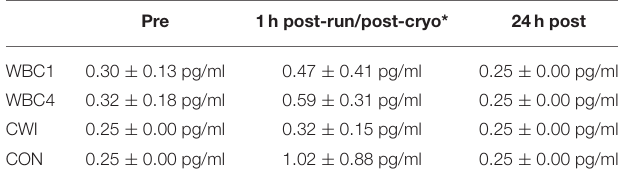
TABLE 3 | Plasma IL-6 response for WBC1, WBC4, CWI, and CON